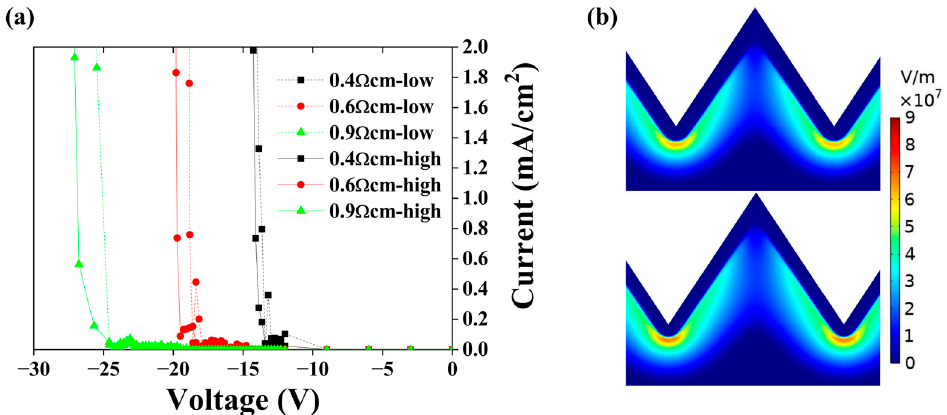
Figure 6. ( a ) Inverse I–V curves of the pyramid-textured structure under different resistivities and doping, where the solid lines and the dashed lines represent high and low doping, respectively; ( b ) the simulated electric field distributions at a resistivity of 0.4 Ω cm for the pyramid-textured surface structure: high doping ( top ) and low doping ( bottom ).